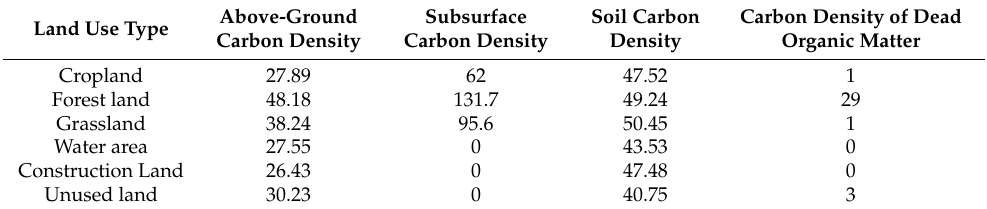
Table 1. Carbon density of different land use types in Yunnan Province (t/hm 2